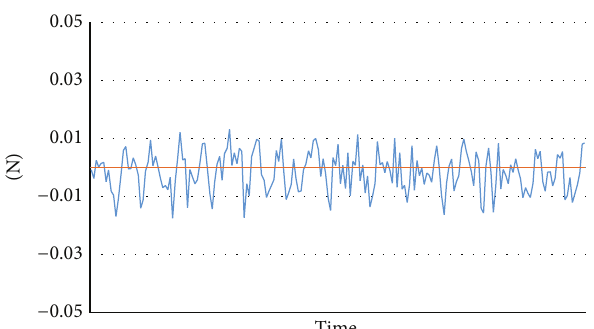
Figure 8: The movement in teleoperation stage.